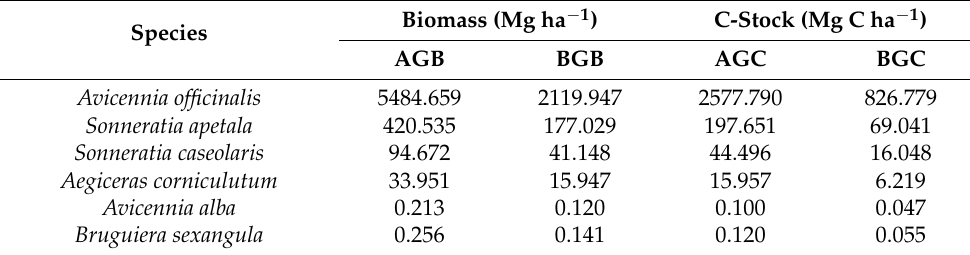
Table 3. Biomass and carbon stock differences among the species in the mangrove stand.